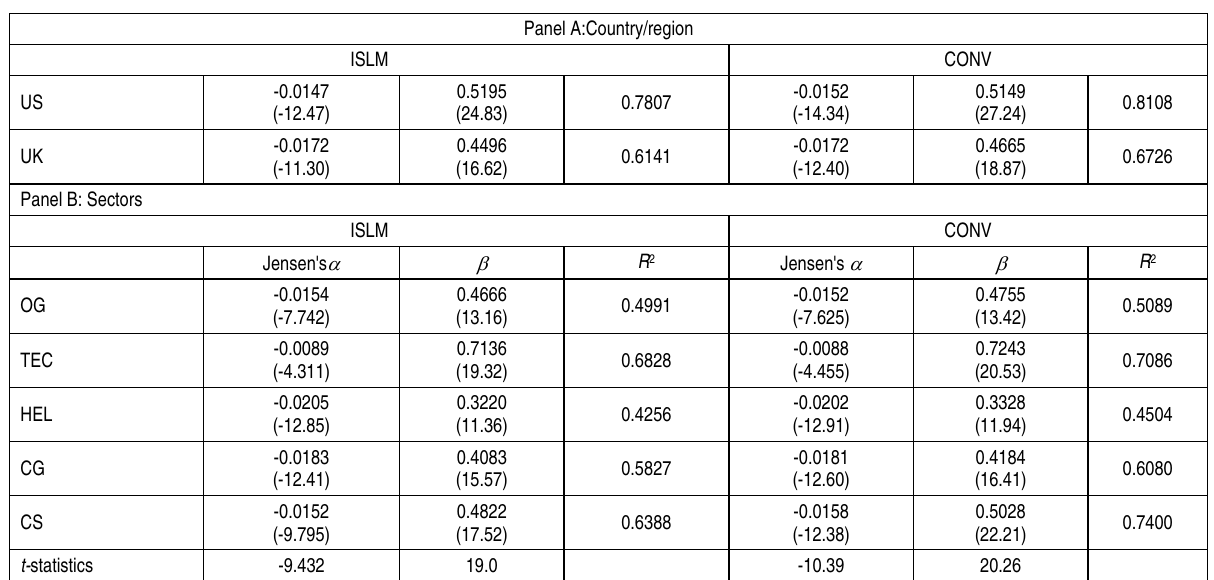
Table 6 (cont.). Estimations CAPM model